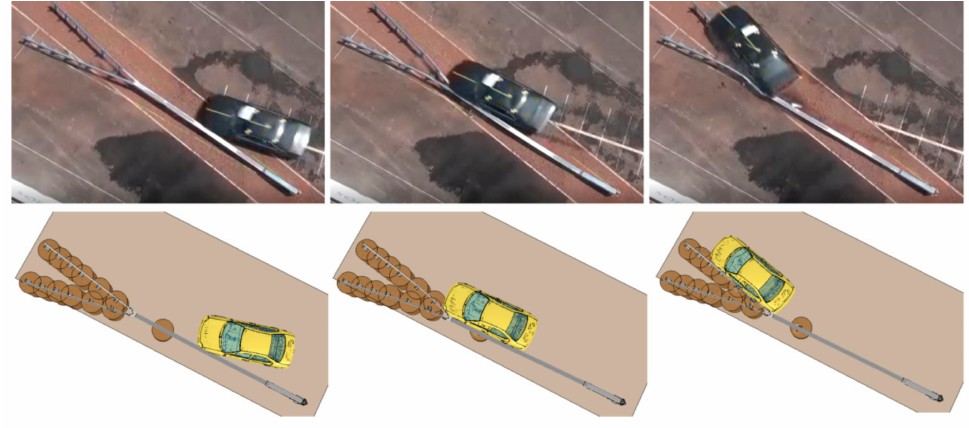
Figure 6. Comparison of the real test ( top ) with the numerical simulation ( bottom ), top down view. Setup of parametric analysis. After validating the numerical model, a parametric analysis was performed. For the parametric analyses, the model was adjusted, i.e., the safety barrier section was extended. In the model the barrier is installed on a horizontal curve. The discretisation of the numerical model for parametric analyses which consists of SafeEnd devices, the w-beam barrier, vehicle and the vehicle’s travel surface, consists